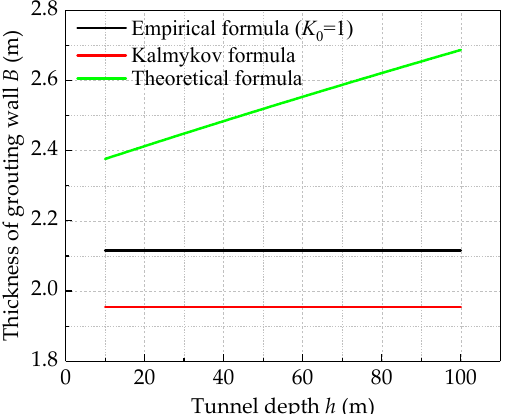
Figure 8. Relationship between concrete retaining wall’s thickness and tunnel’s buried depth.